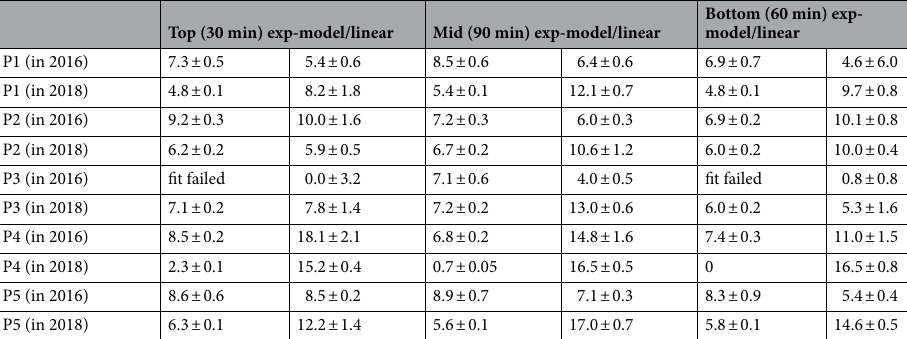
Table 1. Assessment of the SAR (in W/kg) from the measured temperature data for both studies in 2016 and 2018, all donors (P1–P5), and all sample positions in the Mini-TEM cell during the first 30 min of field exposition. In each position, the first number refers to the exponential model with preceding fit of the temperature background and the second number to a linear fit about t = 0